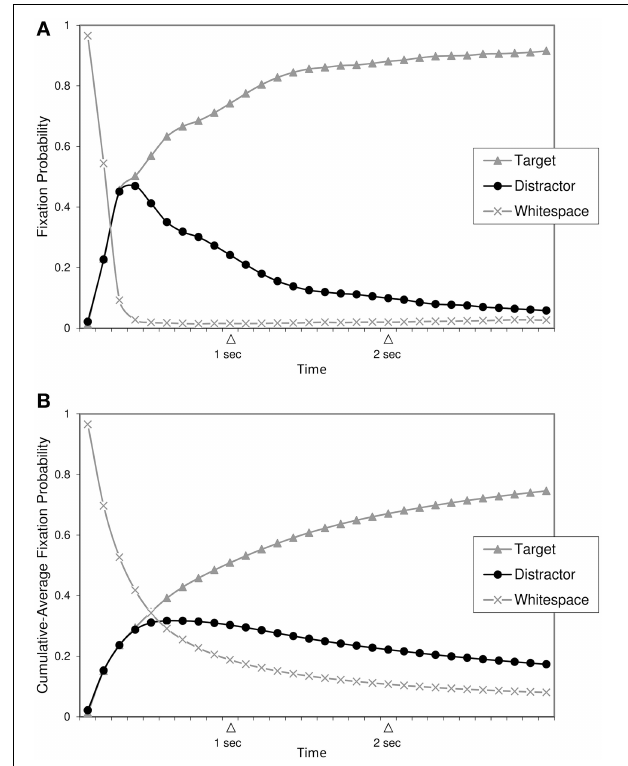
FIGURE 2 | (A) Fixation probabilities per region over time. (B) Cumulative-average fixation probabilities per region over time. Regions of interest are the Target word, the Distractor non-word, and Whitespace (any other